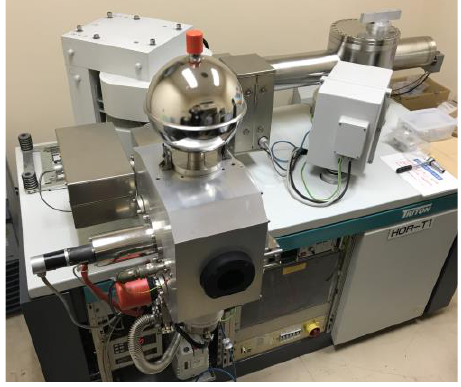
Fig. 5. Thermal ionization mass spectrometer (TIMS). Table 2. Impurity ratios of the 237 Np, 241 Am and 243 Am samples measured with TIMS.